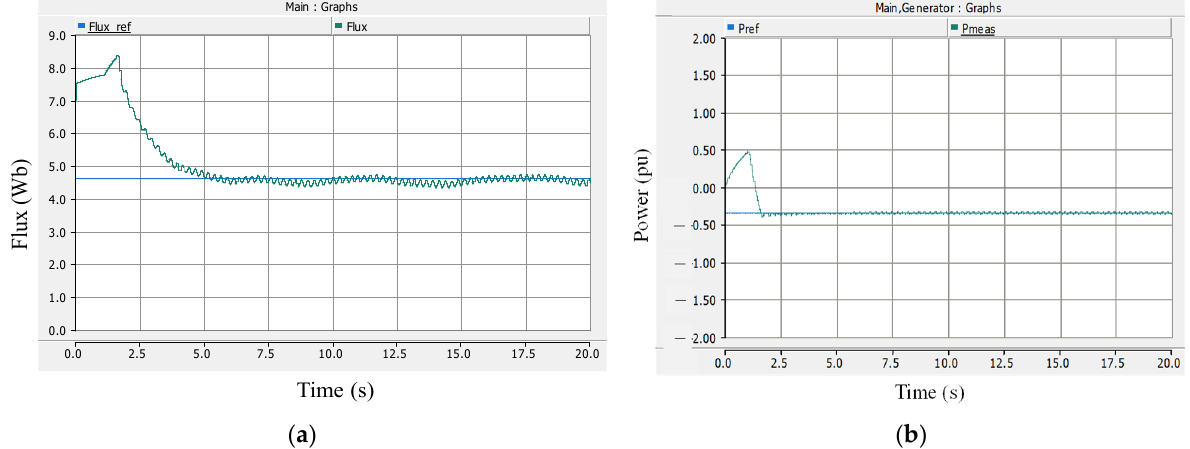
Figure 20. ( a ) Flux control; ( b ) power control at 0.7 pu rotor speed.